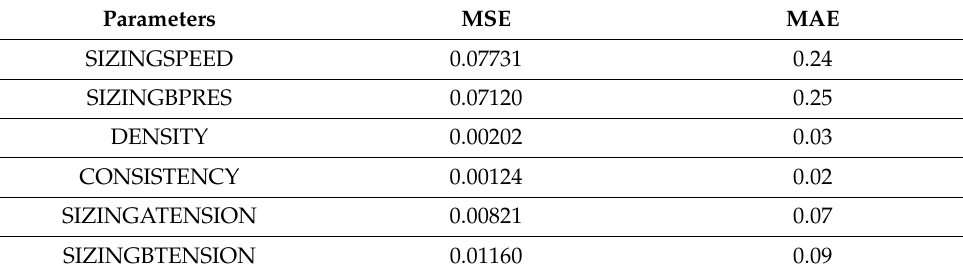
Table 12. Lasso regression results for the sizing